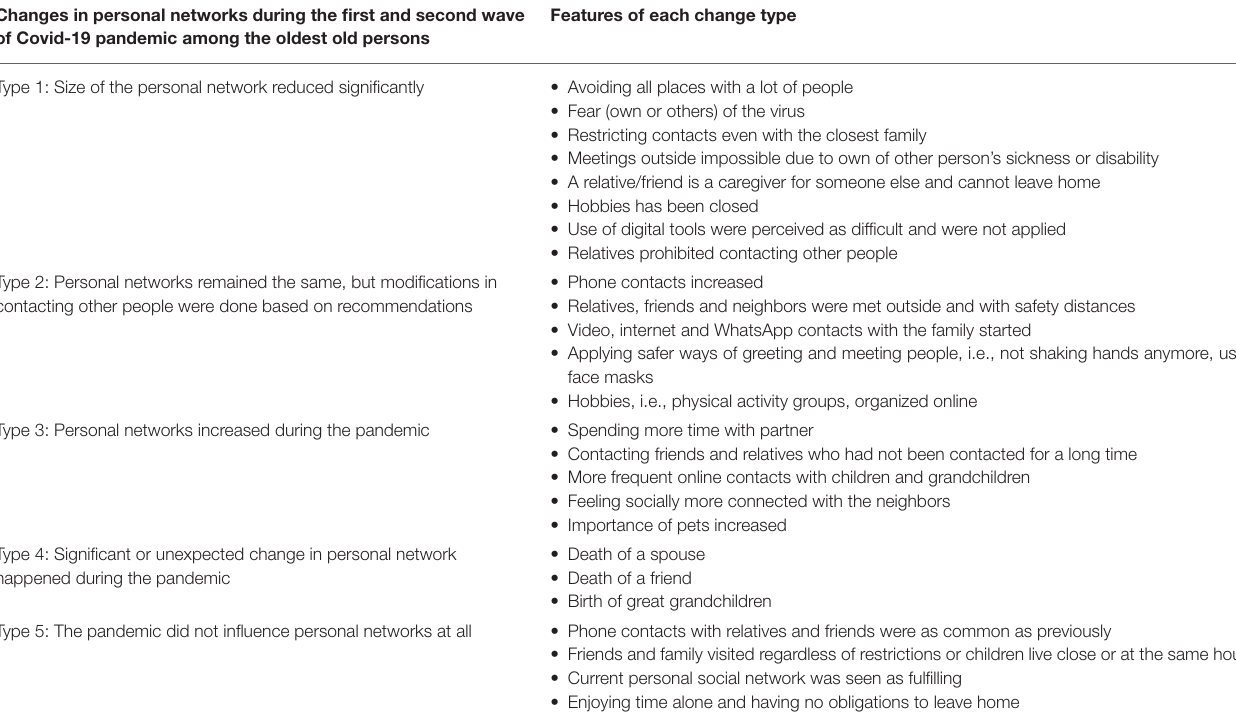
TABLE 2 | Changes in personal networks among the community-dwelling oldest-old persons during the first and second wave of COVID-19 pandemic in Finland. Changes in personal networks during the first and second wave Features of each change of Covid-19 pandemic among the oldest old persons